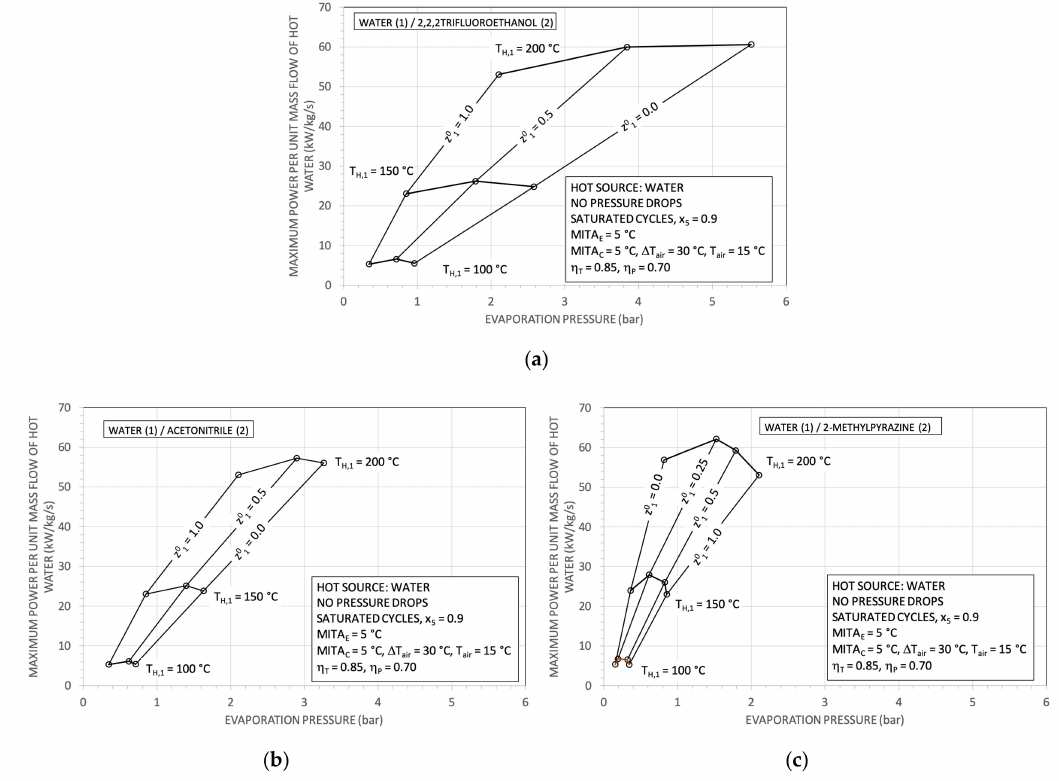
Figure 9. Net power per unit mass flow of hot water as a function of the evaporation pressure. ( b ) water / acetonitrile, ( c ) water /